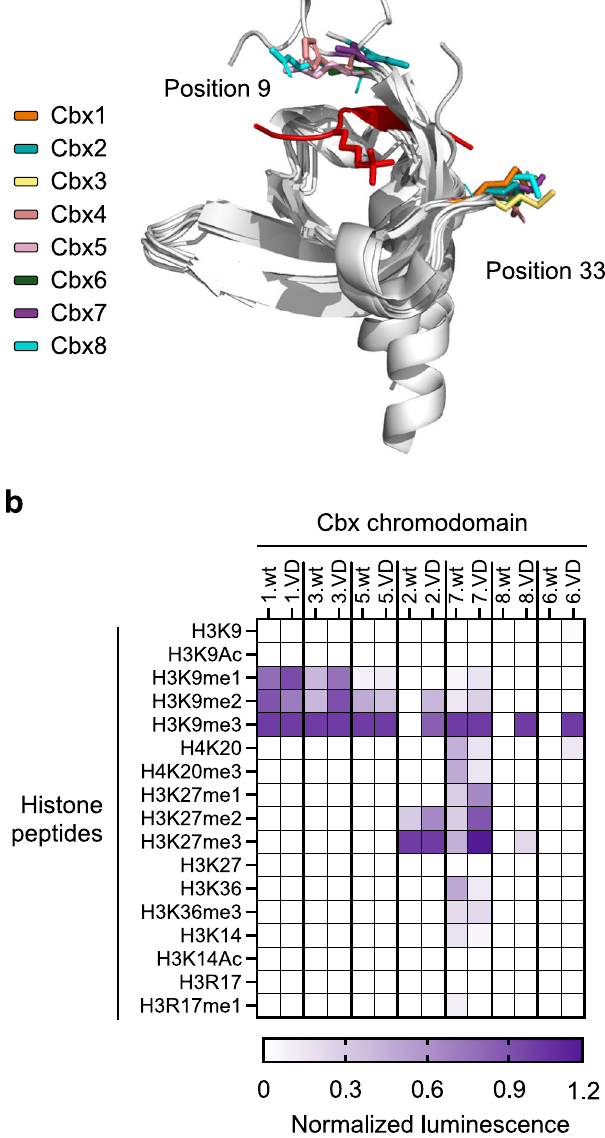
Fig. 2 | Speci fi cities of wild-type and high-af fi nity chromodomains of PcG and HP1familymembers.a SuperpositionofallhumanCbxchromodomainstructures with that of Cbx7 in complex with an H3K27me3 peptide (PDB: 4X3K). The H3K27me3 peptide is shown in red, with the methylated lysine residue shown as sticks.Mainchainsofalldomainsarerepresentedasgrayribbons,andsidechainsof residues atpositions 9 and 33 are shown ascolored sticks (Cbx1, PDB: 3F2U; Cbx2, PDB: 3H91; Cbx3, PDB:3DM1; Cbx4, PDB: 5EPL; Cbx5,PDB:3FDT; Cbx6, PDB: